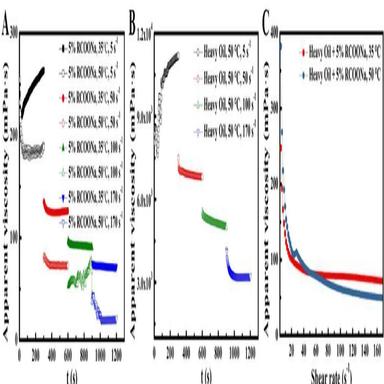
Apparent viscosity as a function of shear rate of (A) 5% RCOONa, (B) heavy oil, and (C) 5% RCOONa þ heavy oil (1:1) at 35 C and 50 C. 5% RCOONa, 5% emulsion viscosity reducer solution.